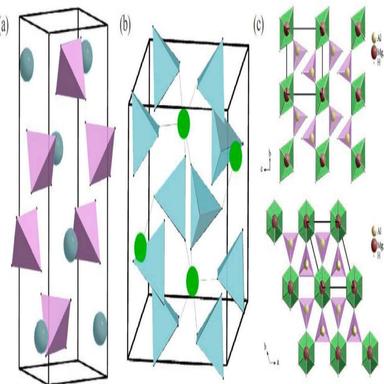
Crystal structure of (a) NaAlD4 and (b) LiAlD4. The tetrahedra represent complex - anions and the black spheres represent Na or Li cations; (c) crystal structure of Mg(AlH4)2. Views along the a-axis (top) and the c-axis (bottom).